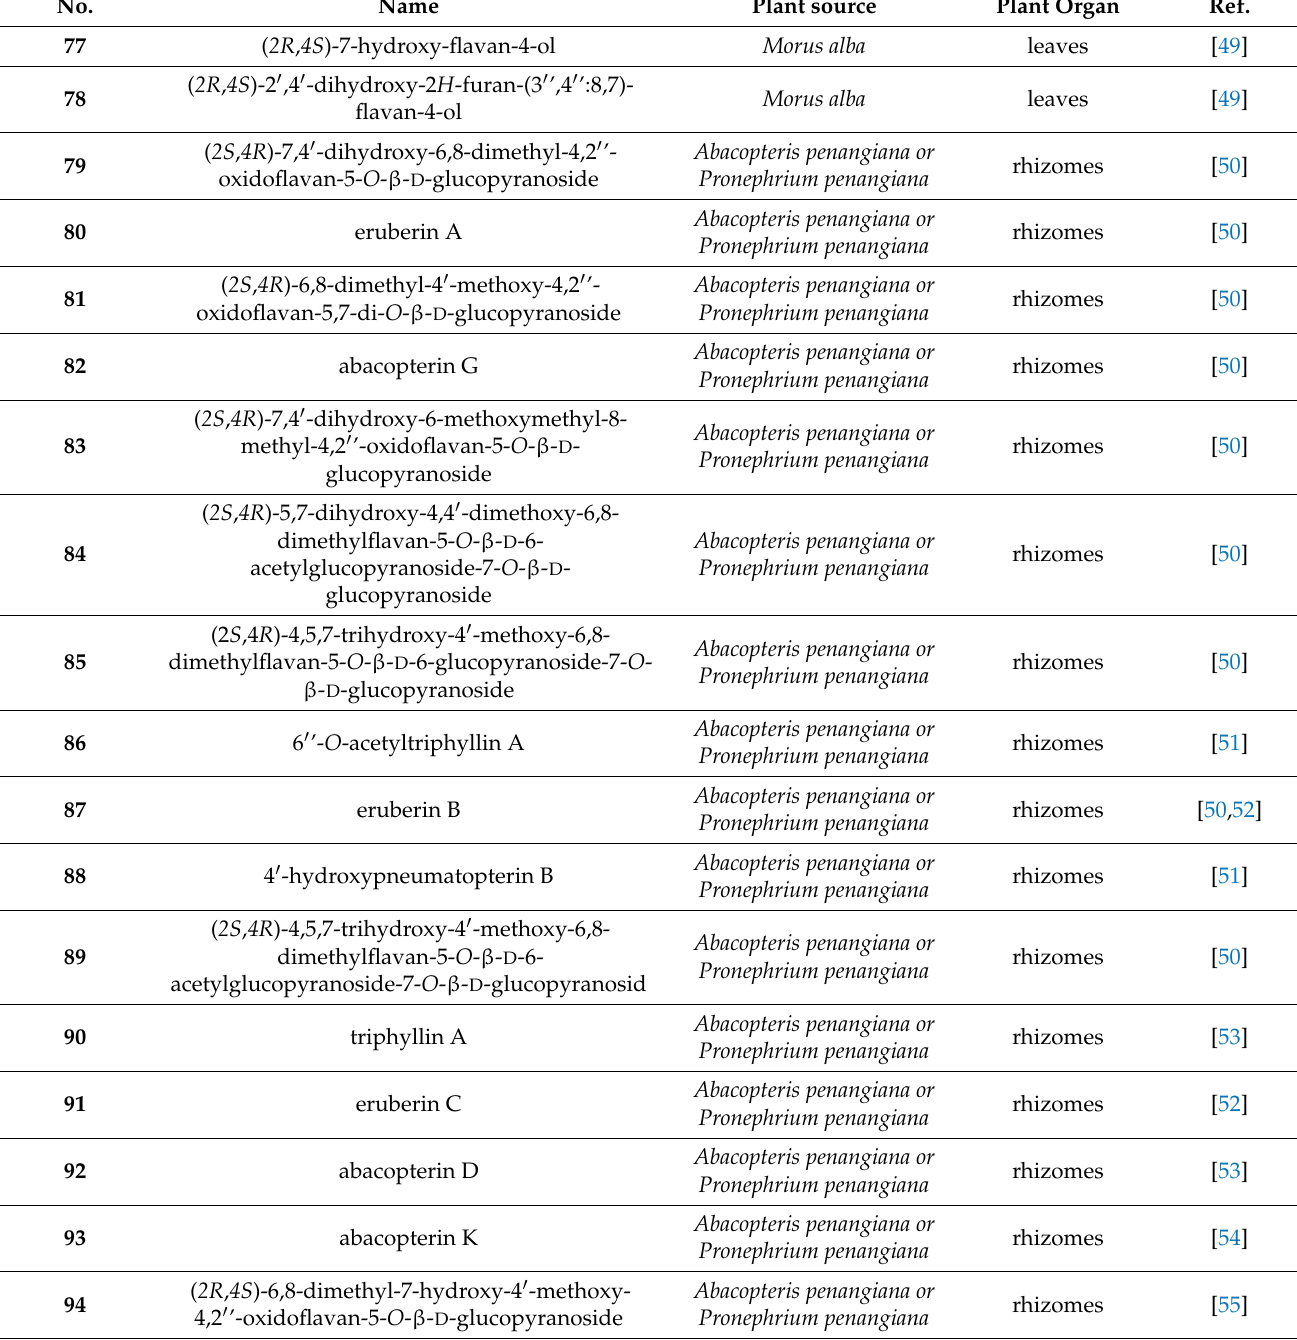
Table 2. The numbers, plant sources and corresponding organs of